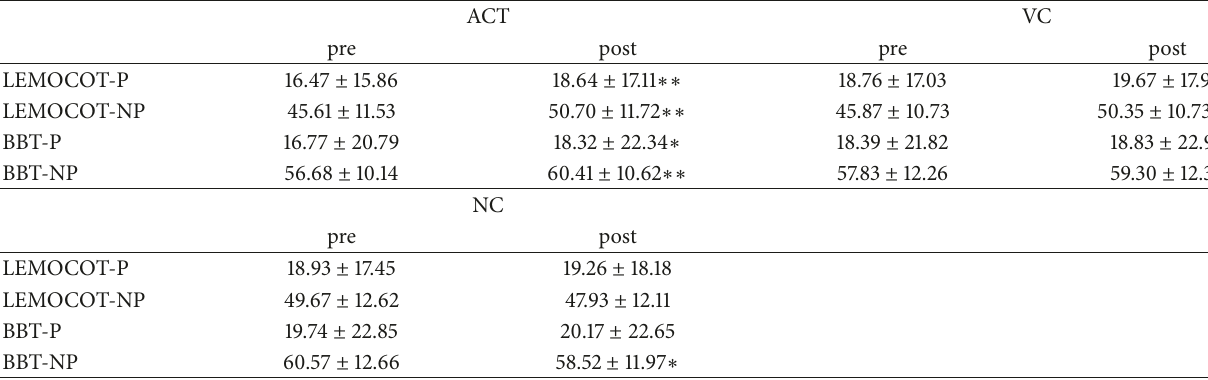
Table 3: Means ± standard deviation for pre- and post-tests in each intervention.